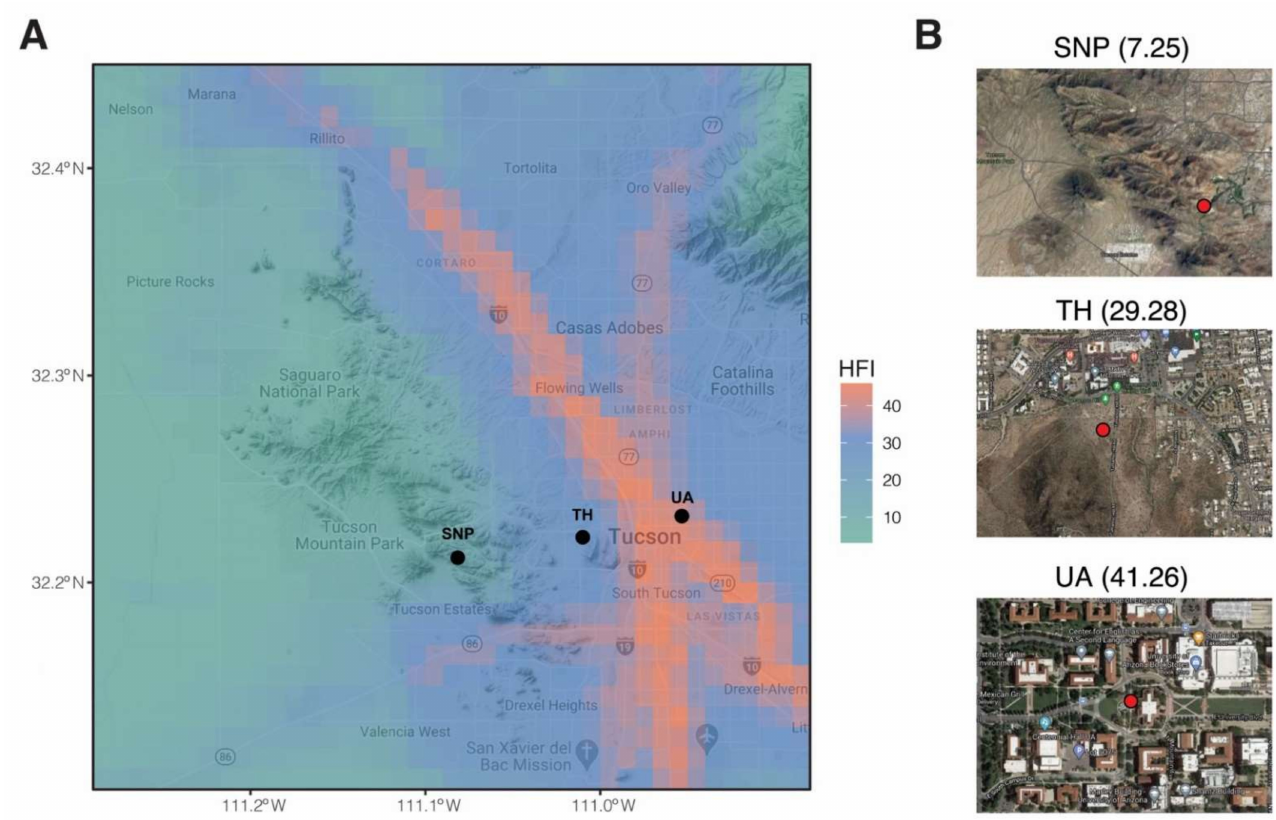
Figure 1. Sampling locations in this study. ( A ) Map is overlayed by human footprint index (HFI). Black points denote sampling locations. ( B ) A zoomed view of each sampling location. Red points denote sampling plots. Numbers in brackets are human footprint index. SNP: Saguaro National Park. TH: Tumamoc Hill. UA: University of